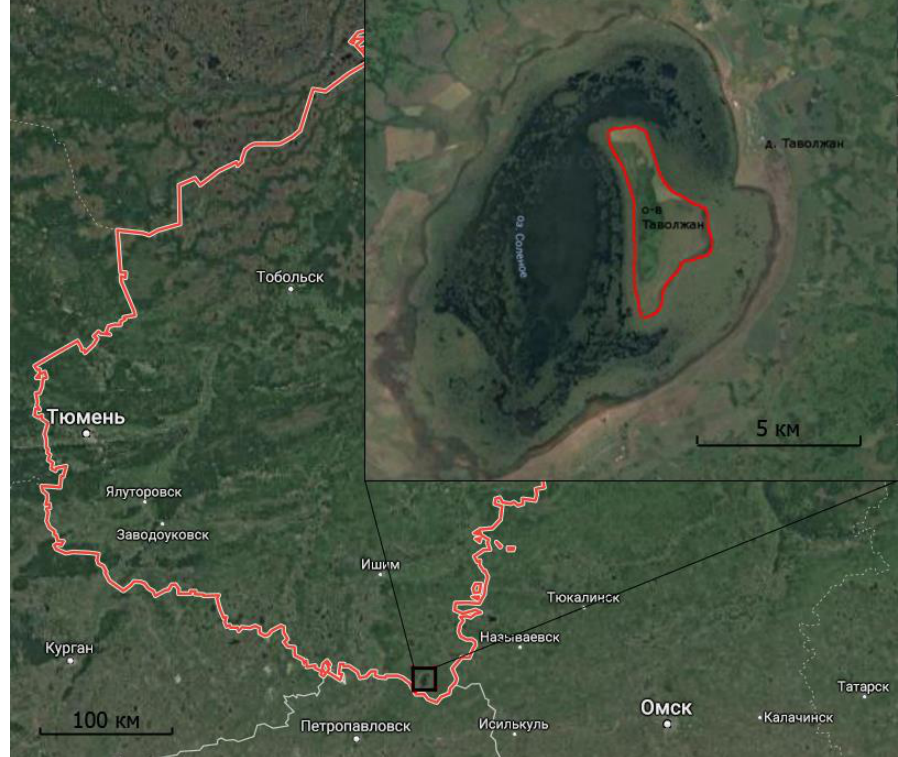
Fig. 1. Map-scheme of the reserve «Tavolzhansky» (Tyumen Region). The boundary of the territory of the reserve is shown in